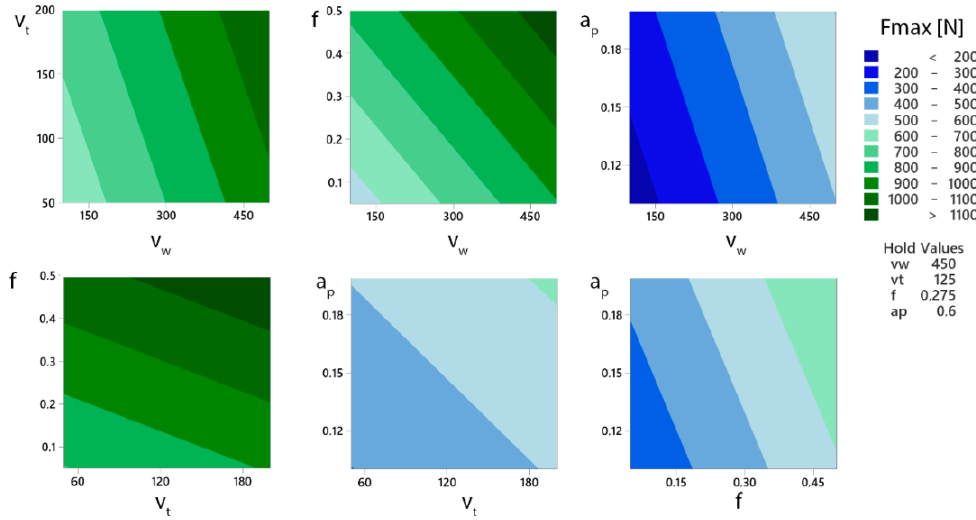
Figure 8. Contour (surface) plot of individual parameters for the total cutting force